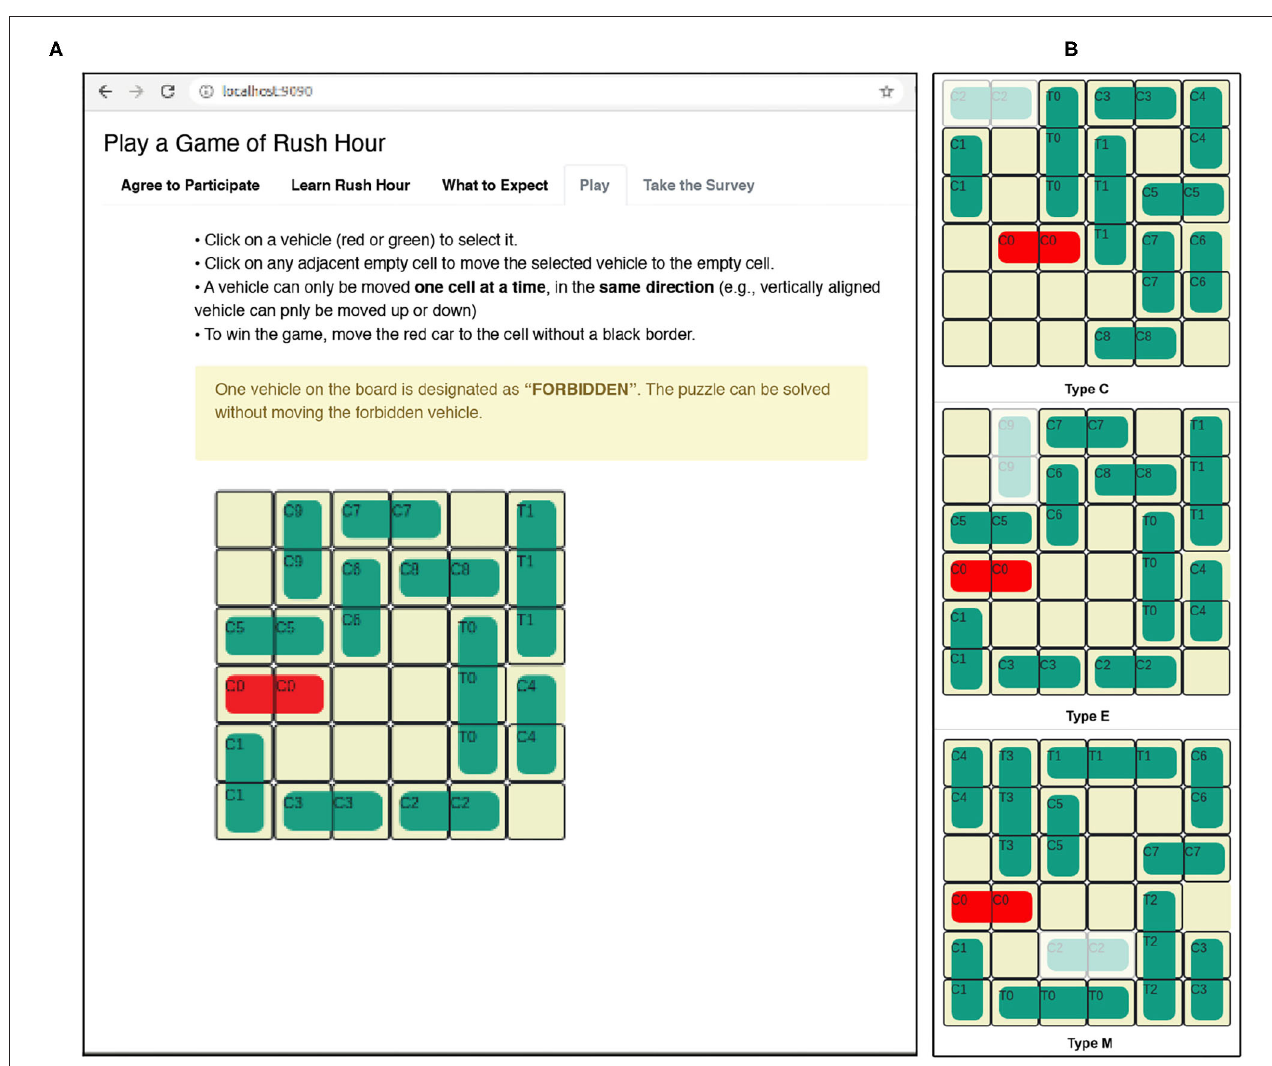
FIGURE 6 | (A) Rush Hour planning task Web interface. The forbidden vehicle for this configuration is C 9 . (B) Rush Hour puzzle configuration types with forbidden vehicles highlighted.